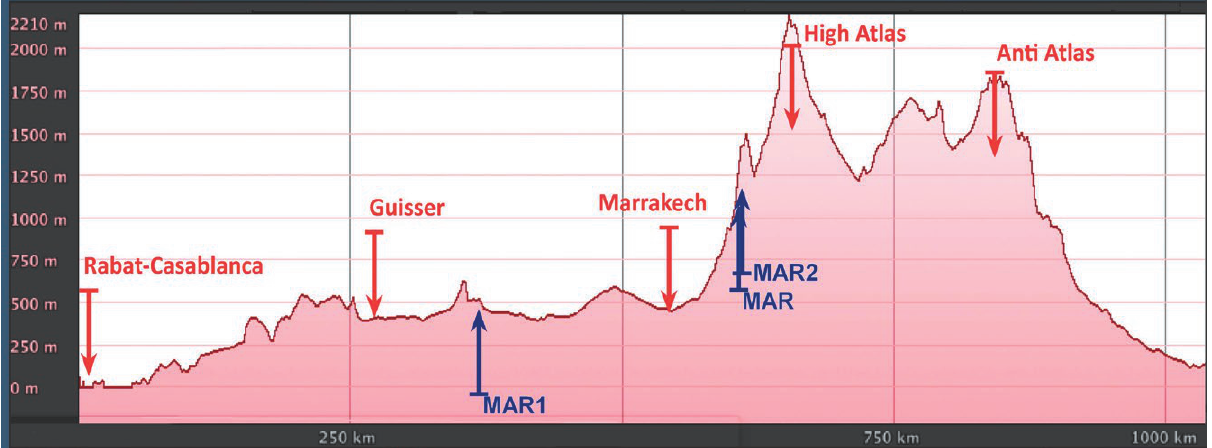
Figure 1. Elevation of the collecting localities in Morocco. MAR: Terketen; MAR1: Beni Mellal; MAR2: